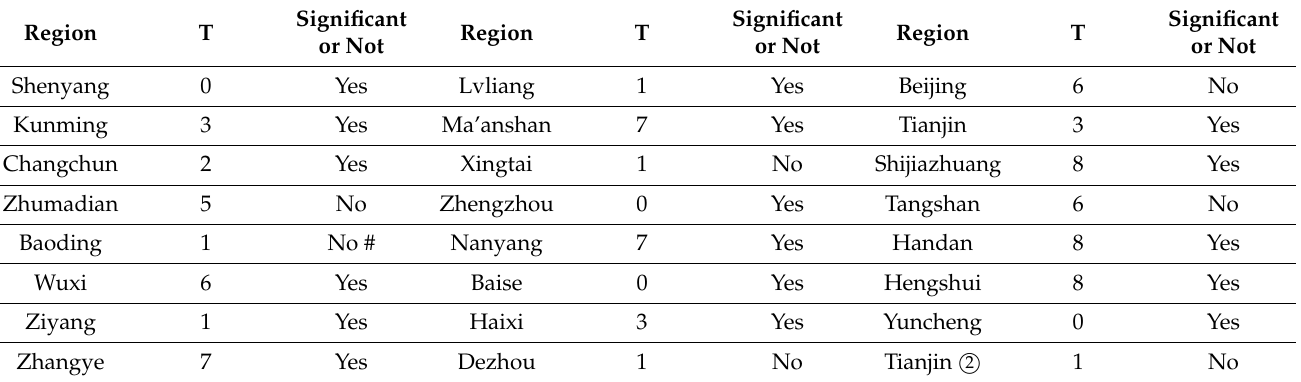
Table 3. List of urban air quality improvement